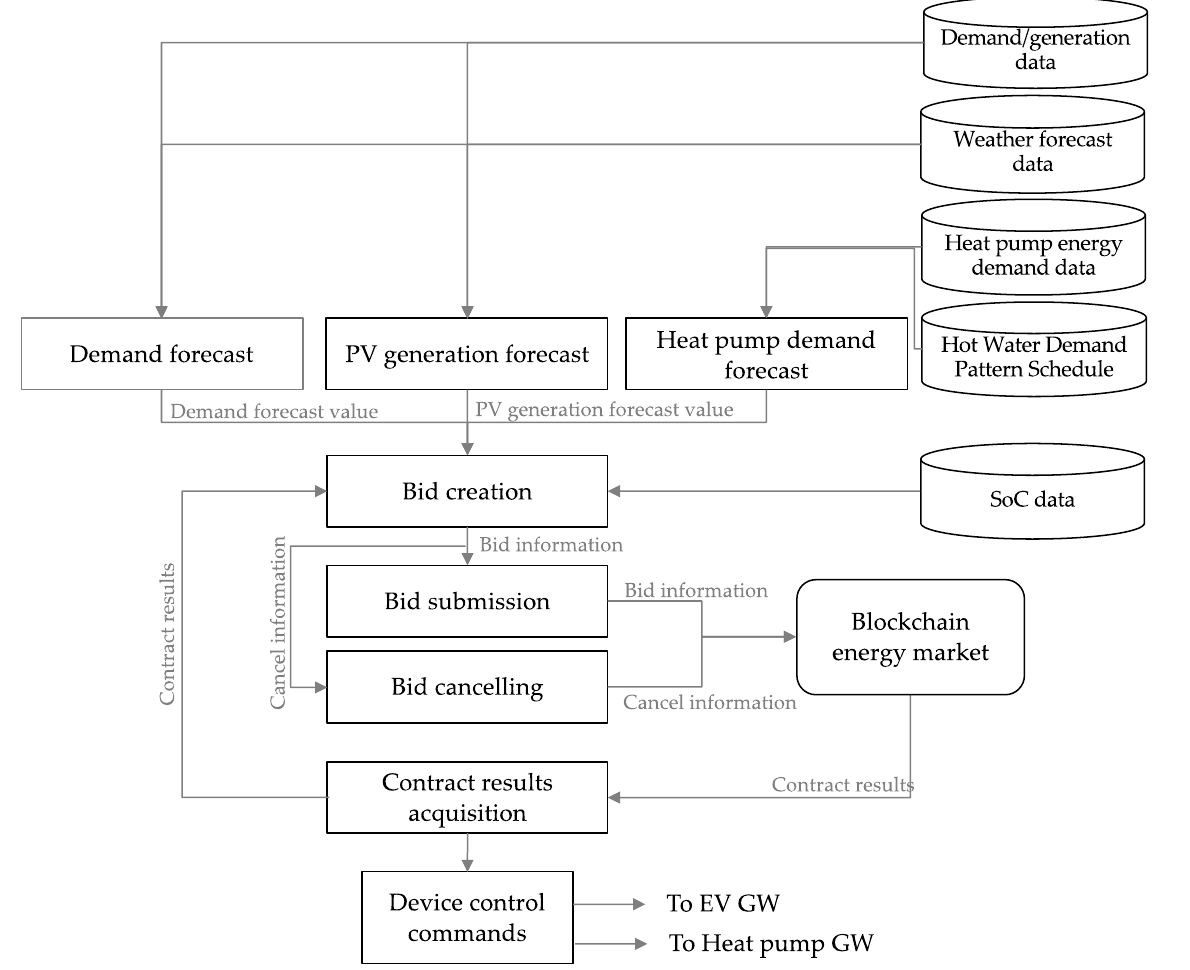
Figure 2. Calculation flow of bidding